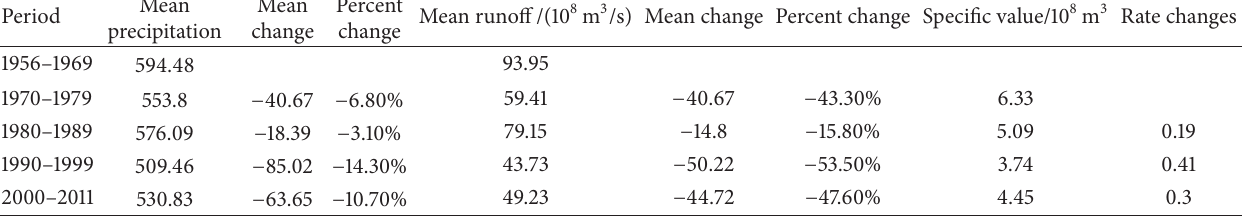
Table 5: Changes in mean precipitation (mm) and runoff (10 8 m 3 ) in the five periods from 1956 to 2011. Period